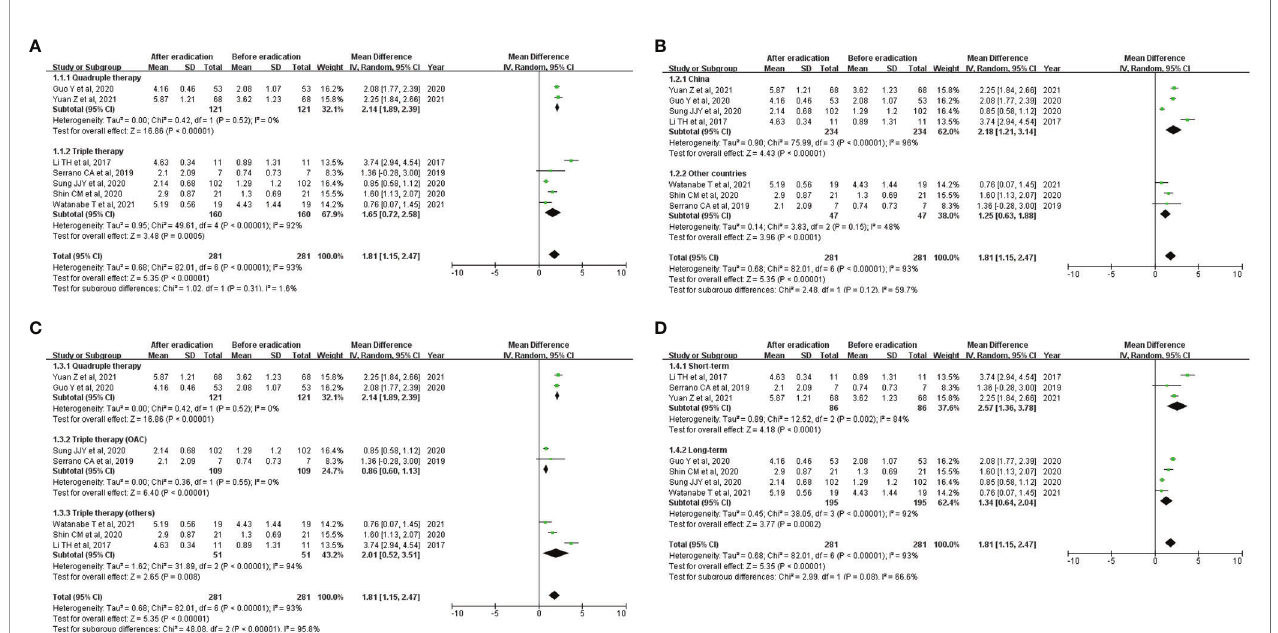
FIGURE 3 | Effect of successful H. pylori eradication on Shannon index. (A) Subgroup analysis according to types of therapy; (B) Subgroup analysis according to countries; (C) Subgroup analysis according to agents; (D) Subgroup analysis according to follow-up period. Forest plots describing weighted mean difference (WMD) with 95% con fi dence interval (CI) for included studies reporting Shannon index. OAC, omeprazole + amoxicillin +